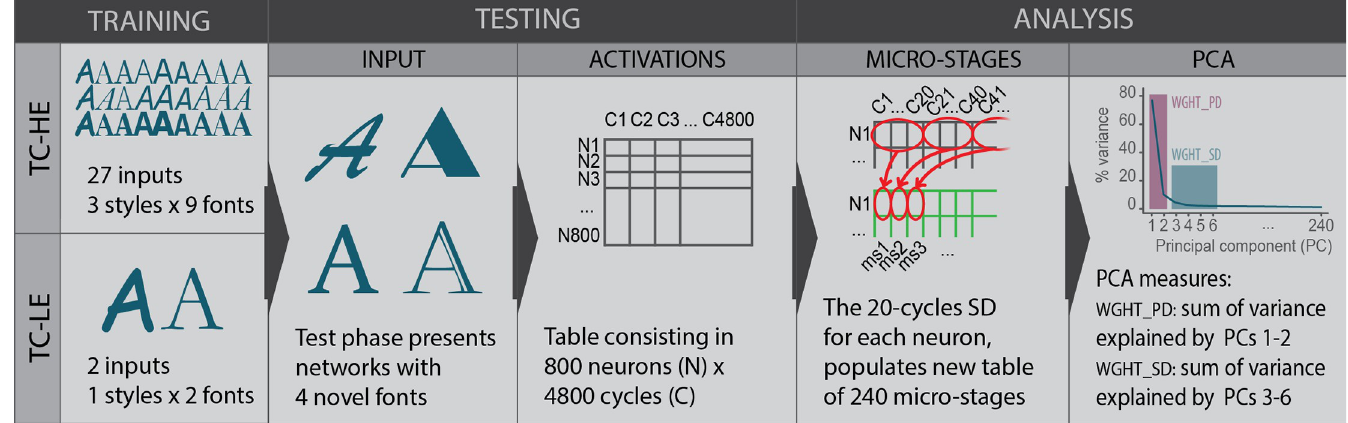
Fig 4. Schematic representation of the analytic procedures employed in the study. The diagram exemplifies the procedures of one TC-LE and one TC-HE network on the ‘A’ letter set of inputs. The same steps were repeated for all other letters and networks. Note that the figure’s fonts are exaggeratedly different in order to better convey the study design. For an example of the actual fonts employed, refer to Fig 3. PCs = principal components.